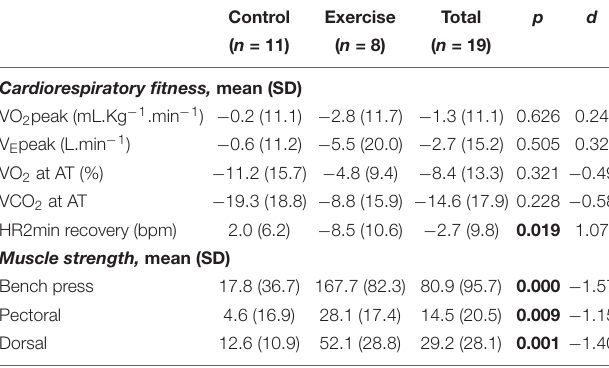
TABLE 2 | Between-group comparisons in percent change from pre to post for cardiorespiratory fitness and muscle strength variables. Control Exercise Total p d